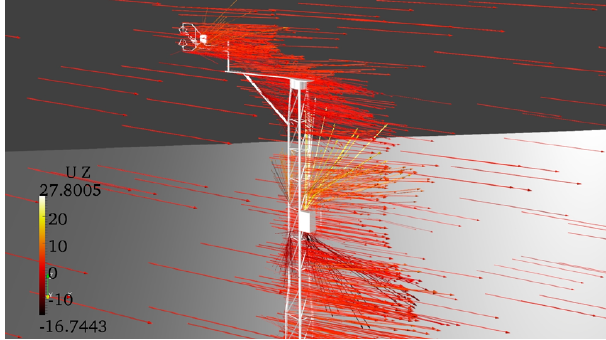
Fig. 12. Cross-sectional velocity vectors scaled from 5 to 25ms − 1 and 0 ◦